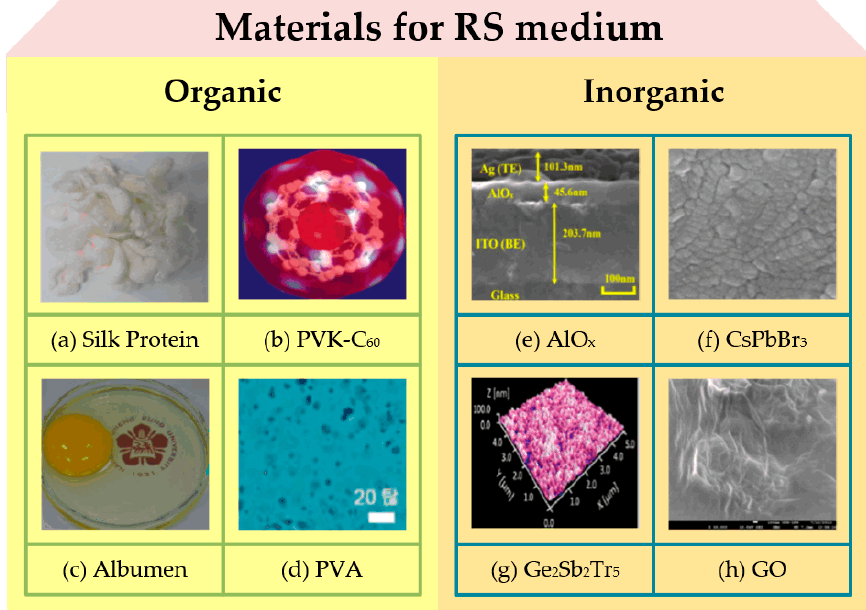
Figure 6. Various thin film materials of RS medium for RRAM devices. ( a ) Silk protein, reproduced from [65], with permission from John Wiley and Sons, 2016. ( b ) PVK-C 60 , reproduced from [72], with permission from American Chemical Society, 2007. ( c ) Albumen, reproduced from [67], with permission from Springer Nature, 2015. ( d ) PVA, reproduced from [71], with permission from John Wiley and Sons, 2011. ( e ) AlO x , reproduced from [19], with permission from Elsevier, 2020. ( f ) CsPbBr 3 , reproduced from [73], with permission from John Wiley and Sons, 2019. ( g ) Ge 2 Sb 2 Tr 5 , reproduced from [38], with permission from John Wiley and Sons, 2019. ( h ) GO, reproduced from [74], with permission from AIP Publishing, 2013.